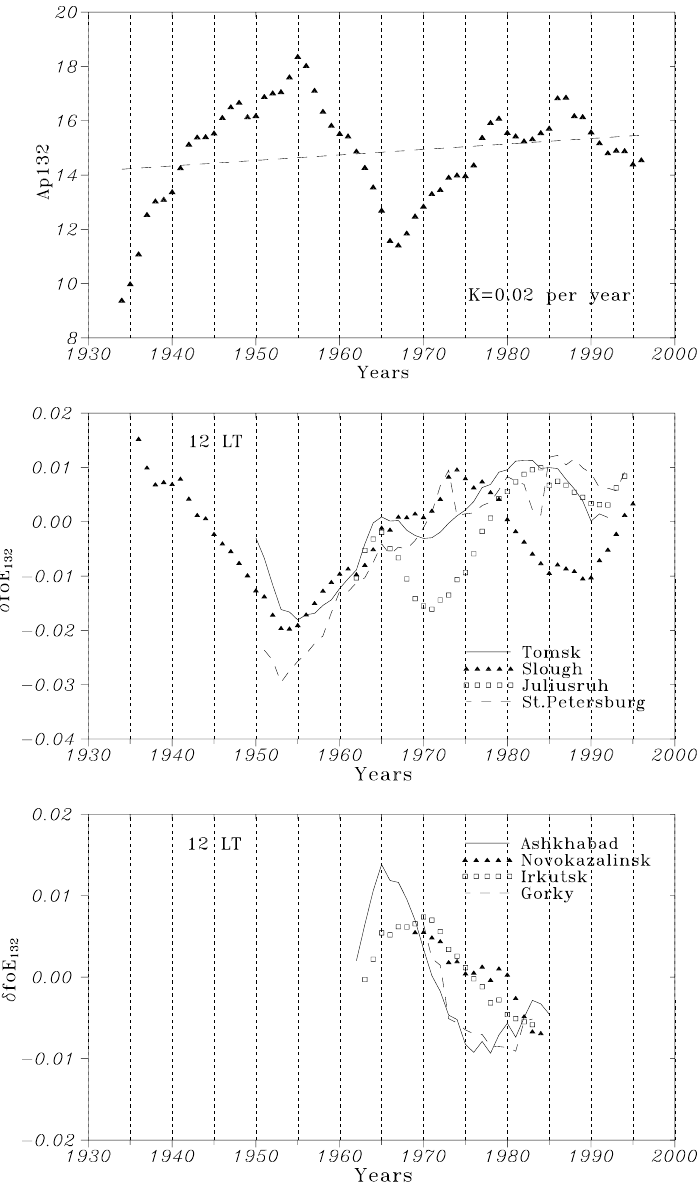
Fig. 1. Long-term variations of geomagnetic activity (top panel) and corresponding δ fo E 132 changes for the stations with different types of δ fo E 132 variations after the end of the 1960s. Note the unsystematic δ fo E 132 variations after the end of the 1960s (middle panel). Dashed line in the top panel is a linear, very long-term trend with the slope K = 0 . 02 per year in geomagnetic activity obtained over the observed Ap 132